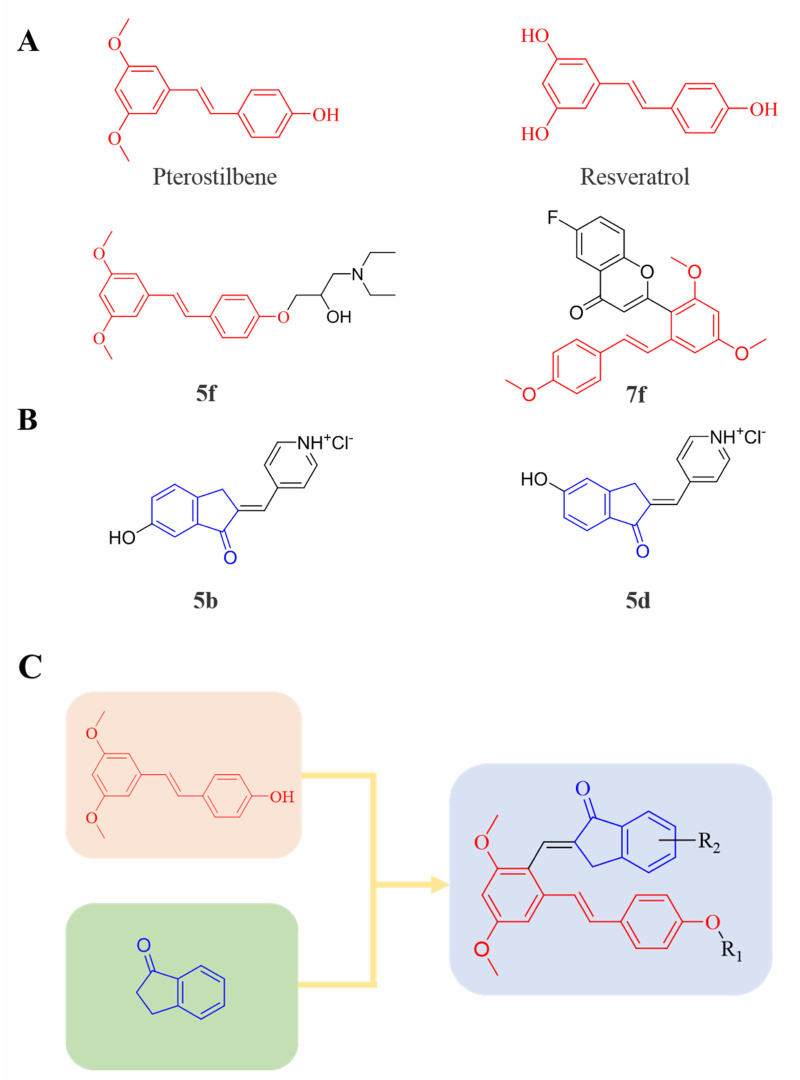
Figure 1. ( A ) Structures of pterostilbene, resveratrol, and their active derivatives 5f and 7f , respec- tively. ( B ) Structures of indanone active derivatives 5b and 5d . ( C ) Design strategy of pterostilbene indanone derivatives (the red part of the structure is pterostilbene, and the blue part is